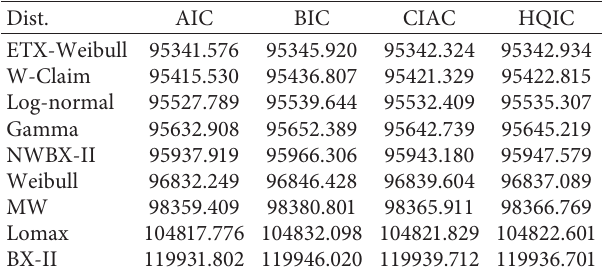
Table 4: The estimated values of the parameters with standard errors (in parenthesis) of the fitted distributions.